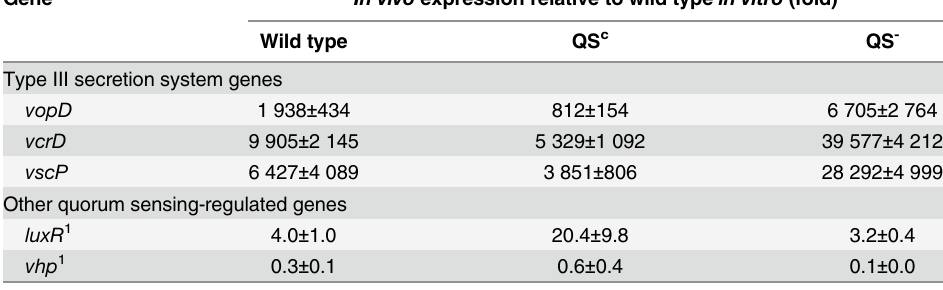
Table 2. Relative expression of the type III secretion system genes vopD , vcrD and vscP , the quorum sensing master regulator gene luxR and the Vibrio harveyi metalloprotease gene vhp in brine shrimp- associated wild type Vibrio harveyi and mutants with the quorum sensing system locked in high cell density configuration (QS c ) and the quorum sensing system locked in low cell density configuration (QS - ), respectively, after 12h challenge. The expression in wild type Vibrio harveyi in vitro (in Marine Broth) was set at 1 and the in vivo expression levels for all strains were normalised accordingly using the 2 - ΔΔ CT method. The RNA polymerase A subunit ( rpoA ) mRNA was used as an endogenous control. Gene In vivo expression relative to wild type in vitro (fold) Wild type QS c QS